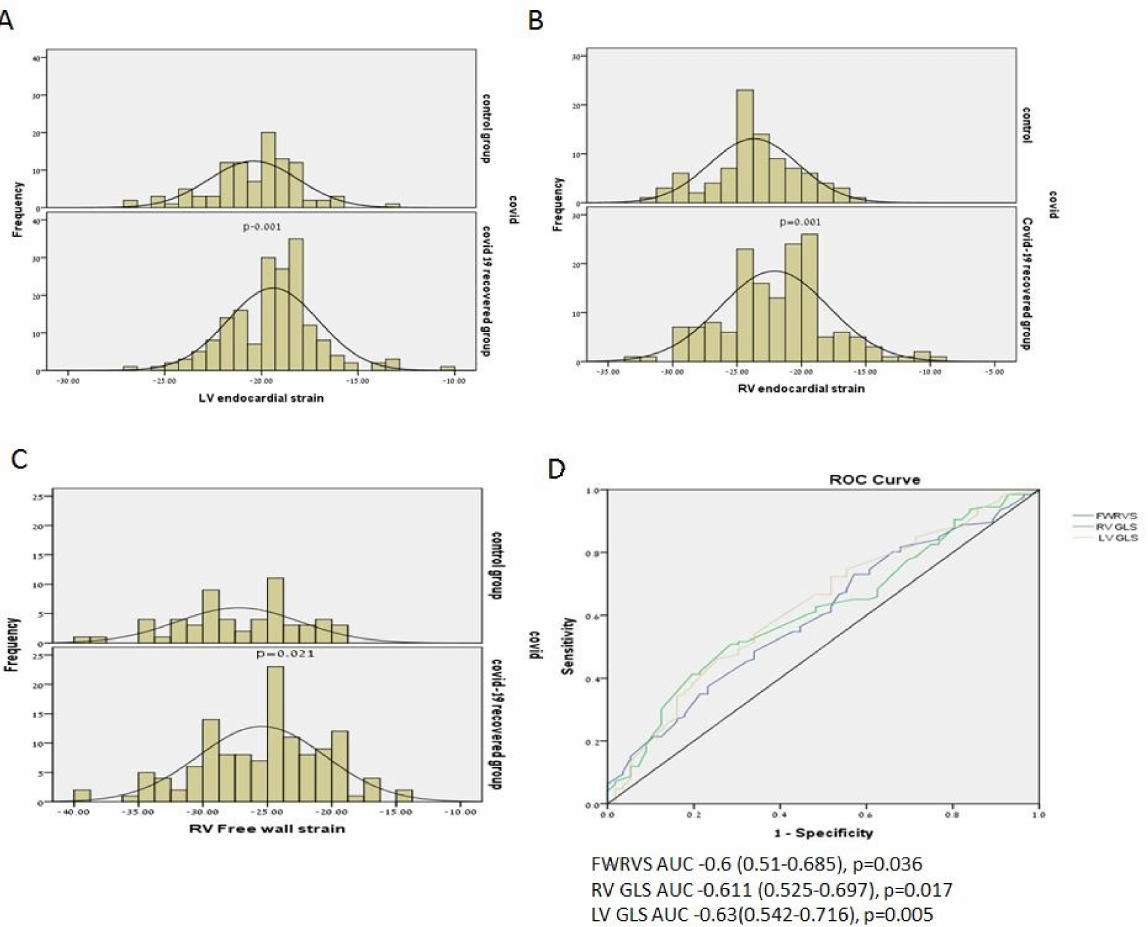
Figure 2. ( A ) Left GLS in COVID-19 recovered patients and controls. ( B ) Right ventricular strain in COVID-19 recovered patients and controls. ( C ) Free wall right ventricular strain in COVID-19 recovered patients and controls. ( D ) ROC for relation between LV, RV and RV free strain and history of COVID-19